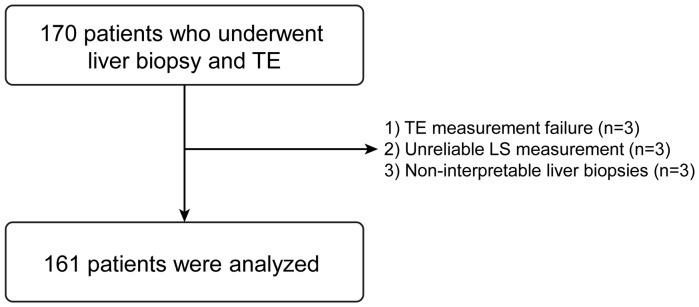
Recruitment algorithm.A total of 170 patients with CLD were consecutively enrolled. However 9 patients were excluded due to TE measurement failure (n = 3), unreliable LS measurement (n = 3), non-interpretable liver biopsies (n = 3), leaving 161 patients to be included in the statistical analysis. CLD, chronic liver disease; TE, transient elastography; LS, liver stiffness.